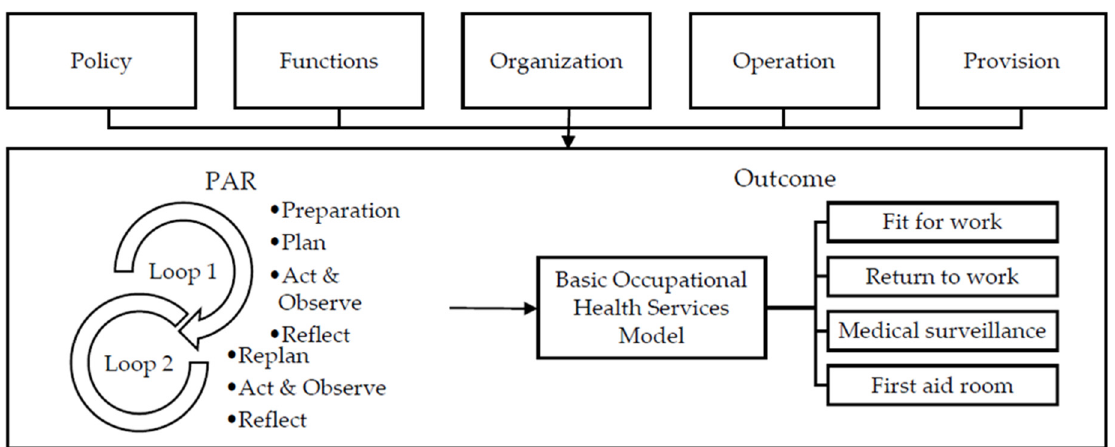
Figure 1. Conceptual framework of PAR cyclical